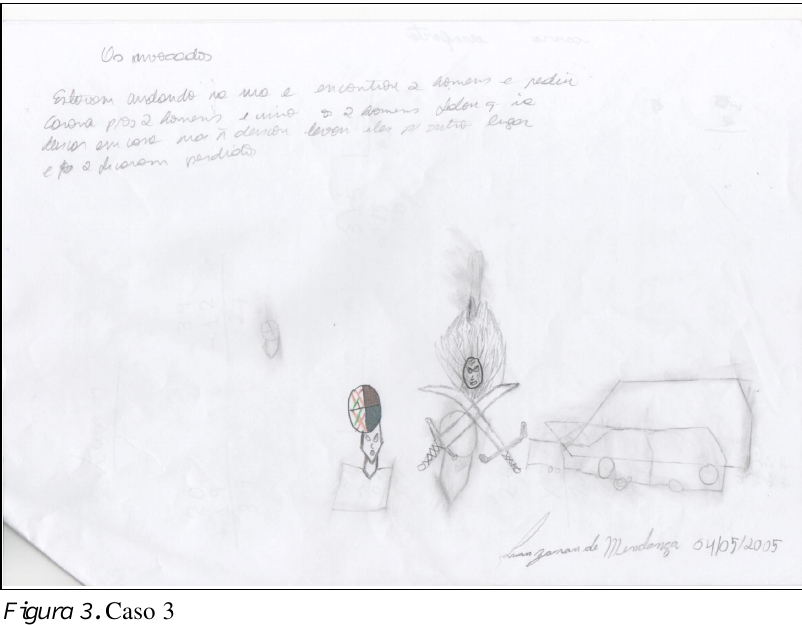
Os invocados “Estavam andando na rua e encontrou dois homens e pediu carona para os dois ho- mens e nisso os dois homens falou que ia deixar em casa, mas não deixou e levou eles para outro lugar e os dois ficaram